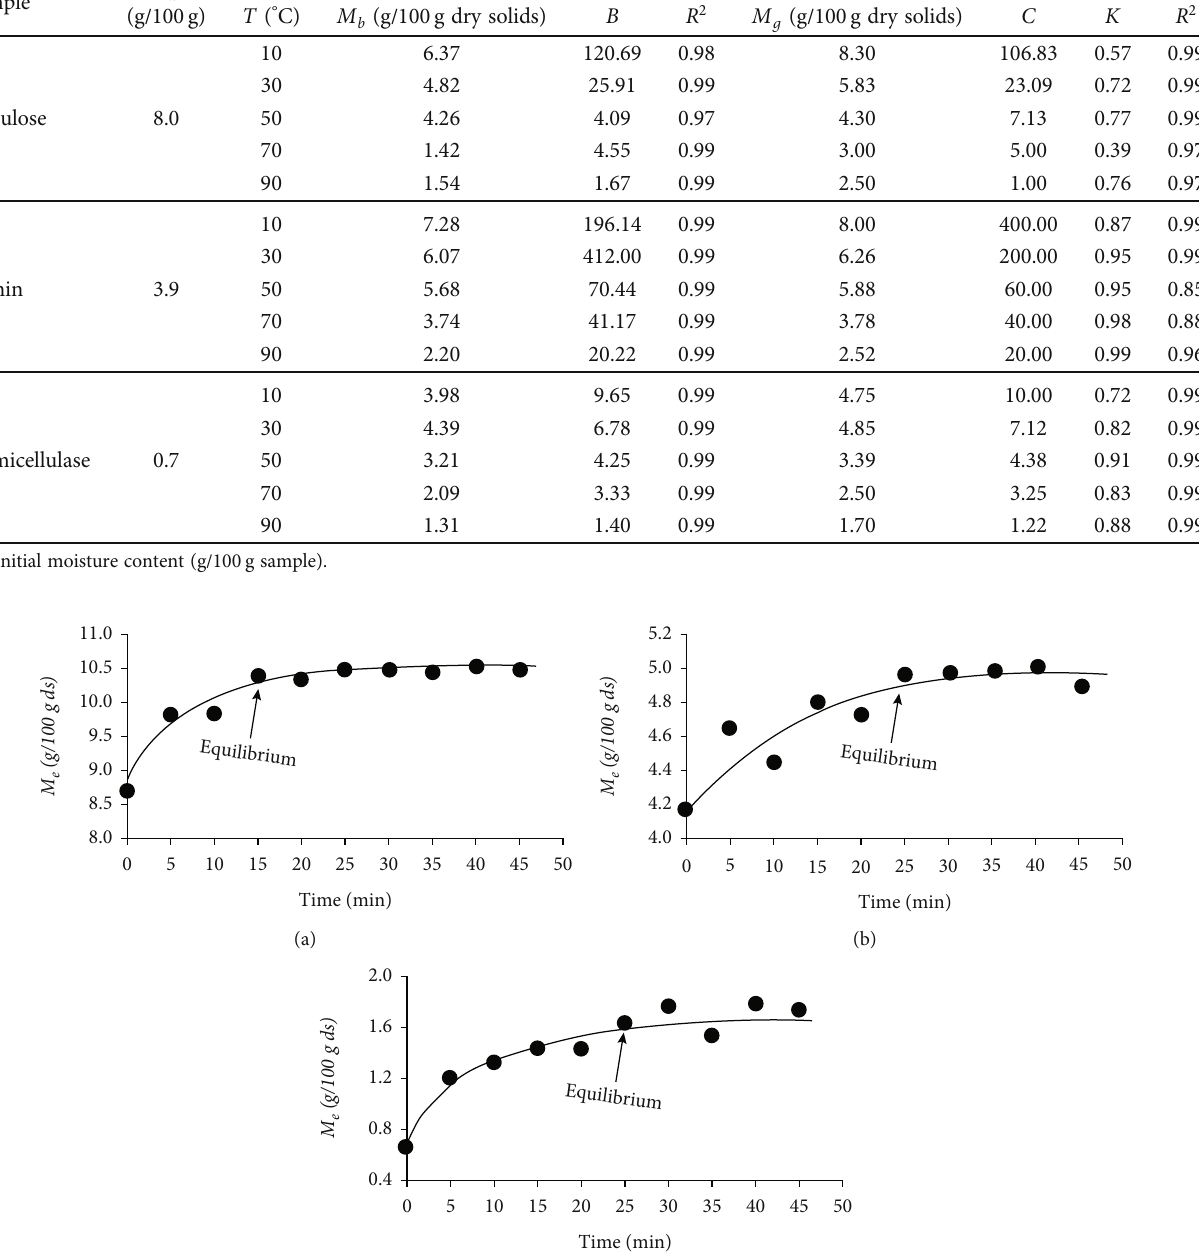
Table 1: BET and GAB models ’ parameters for commercial fi bers and the enzyme hemicellulase. BET model parameters X w Sample